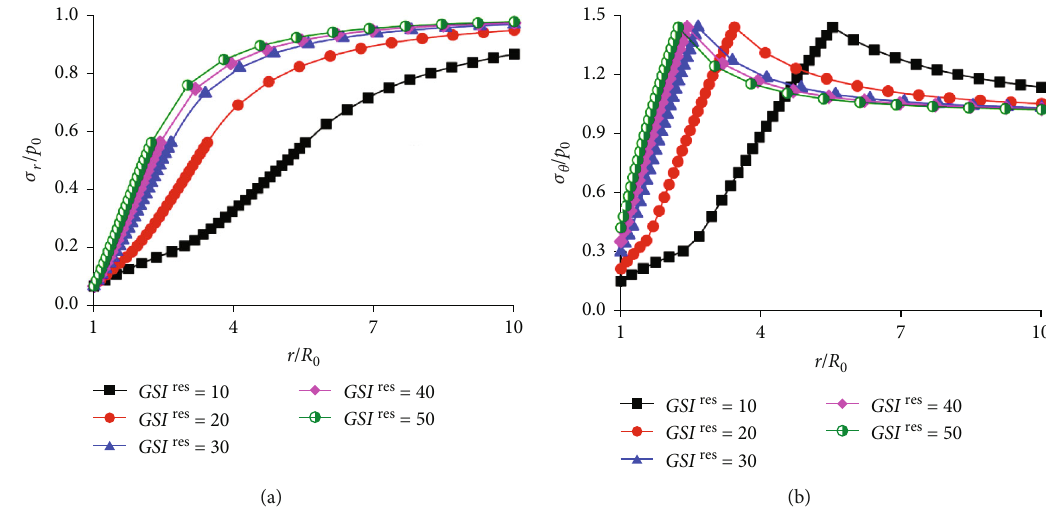
Figure 13: Stress curves with di ff erent GSI res ((a) radial stress; (b) tangential stress).